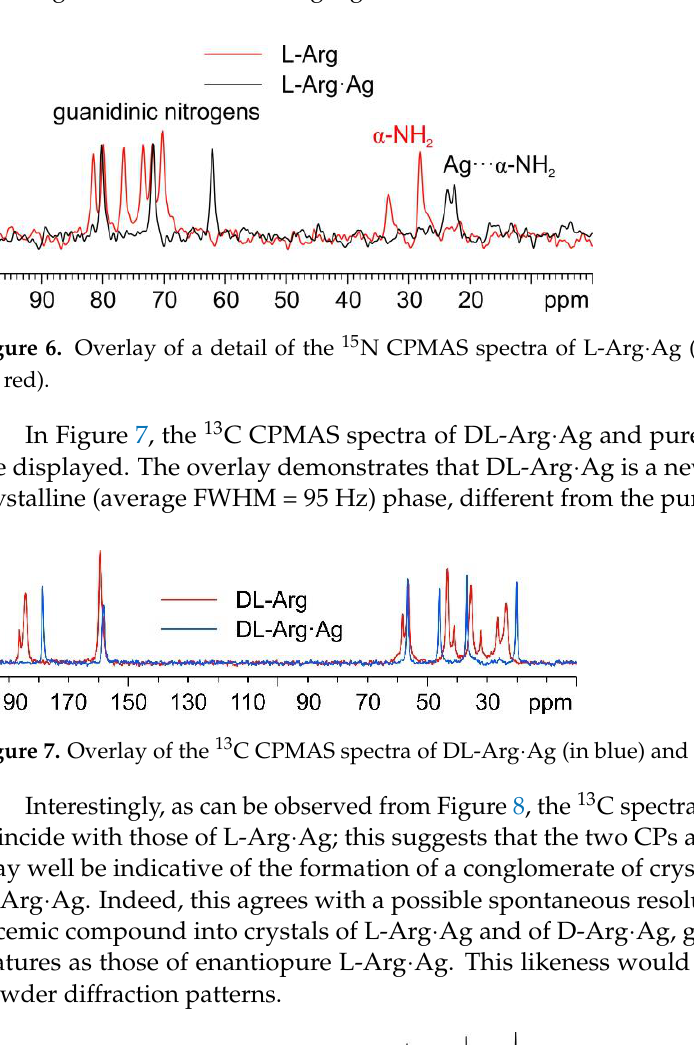
Figure 9. From bottom to top: calculated pattern from single-crystal data of IWOFUX (L-Arg·Ag) in red), experimental powder pattern of L-Arg·Ag (in black), and experimental powder pattern. 2.2.2. L-Arg·Ag and DL-Arg·Ag As mentioned above, in the case of the L-histidine complexes for the sake of the iden- tification of the reaction products, it is necessary to consider the formation of both the 1:1 and 1:2 compounds, namely, L-His·Ag and L-His 2 ·Ag. Figure 10 shows the comparison between the 13 C CPMAS spectra of L-His 2 ·Ag and pure L-histidine (L-His). A pure crys- talline (average FWHM = 72 Hz) phase, different from the pure amino acid, was obtained, characterized by the presence of two independent molecules of L-His in the unit cell. Figure 10. Overlay of the 13 C CPMAS spectra of L-His 2 ·Ag (in purple) and pure L-His (in red). Figure 11 displays an overlay of the 15 N CPMAS spectrum of L-His 2 ·Ag with that of pure L- His. From the comparison, it is easy to notice how the α -NH 3+ group of the pure amino acid stays charged in the coordination polymer, with the aromatic δ nitrogen being the one that binds the silver nucleus. This is proved by the shift of its 15 N signal from 245.7 ppm in pure L-His to 211.6 and 208.5 ppm (isotropic values) in the coordination polymer, for which the signals of both molecules of L-His are split by the 107/109 Ag- 15 N J-coupling [61].